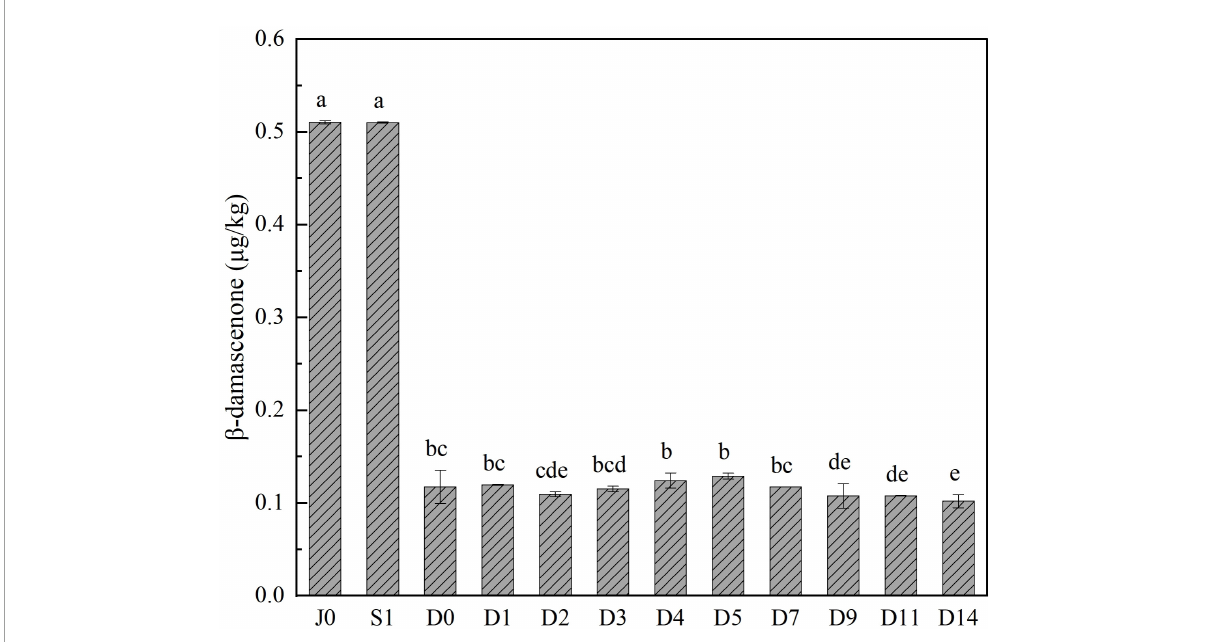
FIGURE1 Change of β -damascenone contents during light-flavor Baijiu brewing process. Values (means ± SD, n = 3) with different letters indicate different significance at p < 0.05 (Duncan’s test).